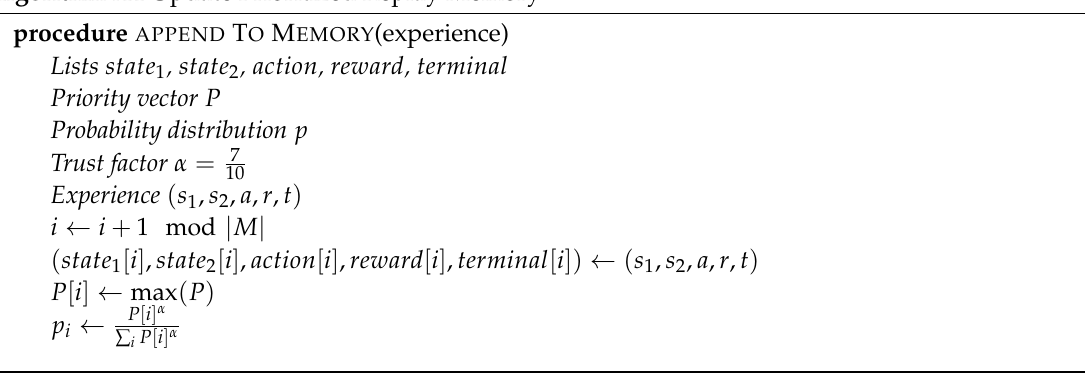
Algorithm A4 Update Prioritized Replay